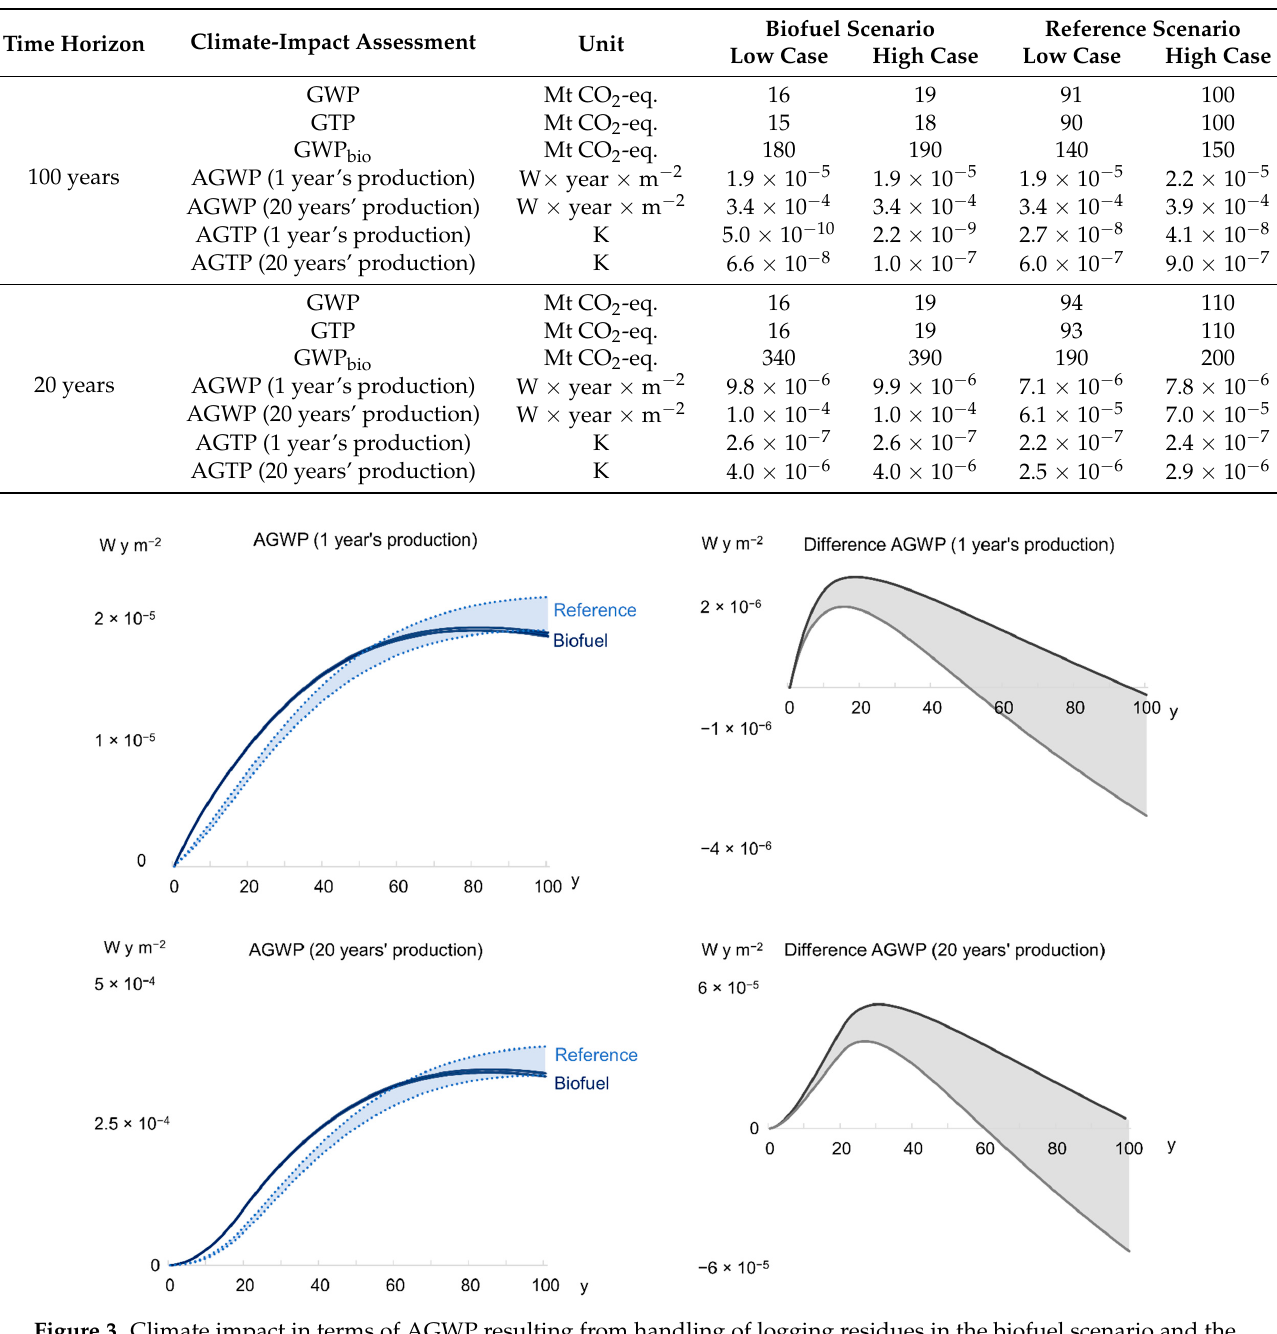
Figure 3. Climate impact in terms of AGWP resulting from handling of logging residues in the biofuel scenario and the reference scenario. The graphs showing climate impact of one year’s production correspond to utilization of 200,000 t DM logging residues, and the graphs showing 20 years of production correspond to utilization of 200,000 t DM logging residues each year for 20 consecutive years. On the right-hand side, the shaded regions show the difference in results for the biofuel and the reference scenario. The upper line shows the climate impact of the high-emission case of the biofuel scenario, with the impact of the low-emission case of the reference scenario subtracted. The lower line shows the climate impact of the low-emission case of the biofuel scenario, with the impact of the high-emission case of the reference scenario subtracted.